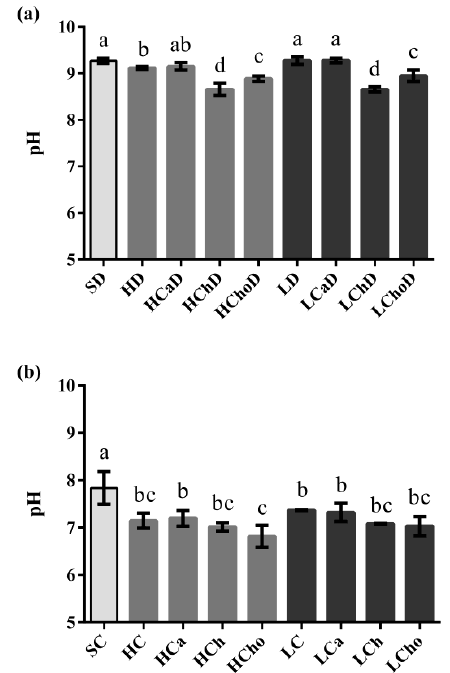
Figure 2. Effect of calcium carbonate, chitosan, and chitooligosaccharide on the pH in brown sugar cookie dough ( a ) and cookies ( b ). a – d Indicate significant difference between different groups (n = 3;